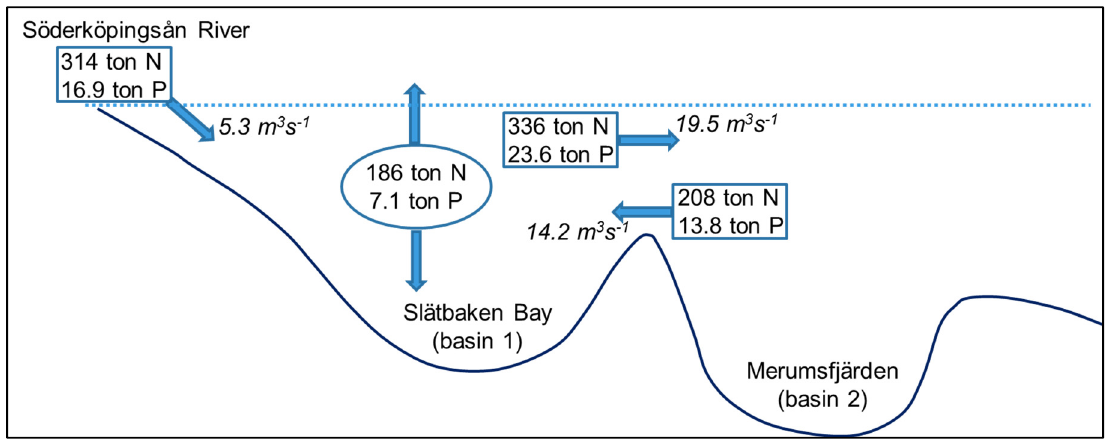
Figure 7. Long term annual means for total N and total P fluxes in the Slätbaken Bay calculated with the coastal zone